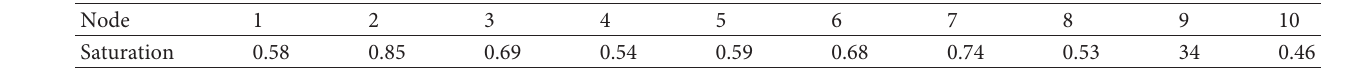
Table 2: Experimental traffic network node saturation.